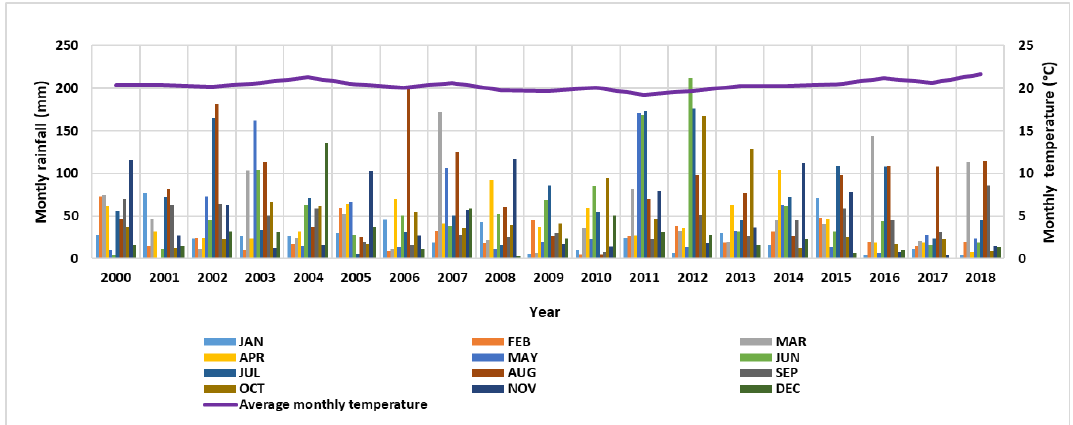
Figure 2. Monthly rainfall (bar graph) and monthly ambient temperature (line) in the Thyspunt area (Data supplied by the NNR).